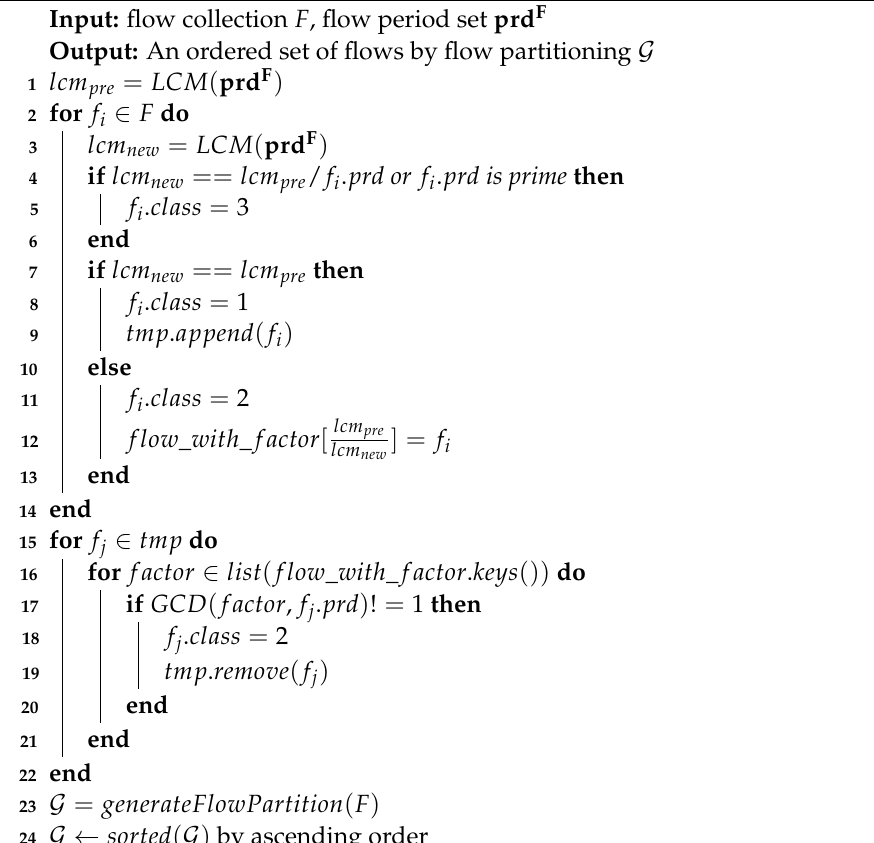
Algorithm 1: Flows classification